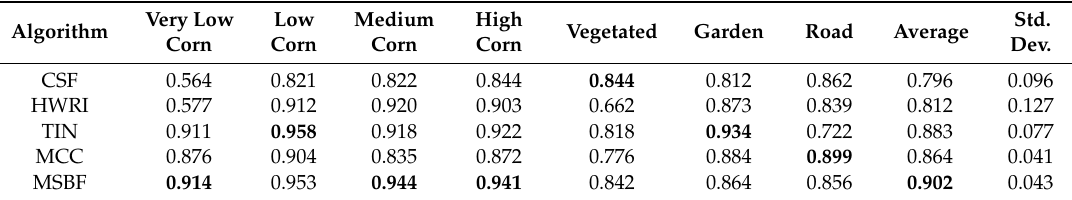
Table 3. Ground point classification kappa results for all sites. The highest kappa score for each site is bolded.